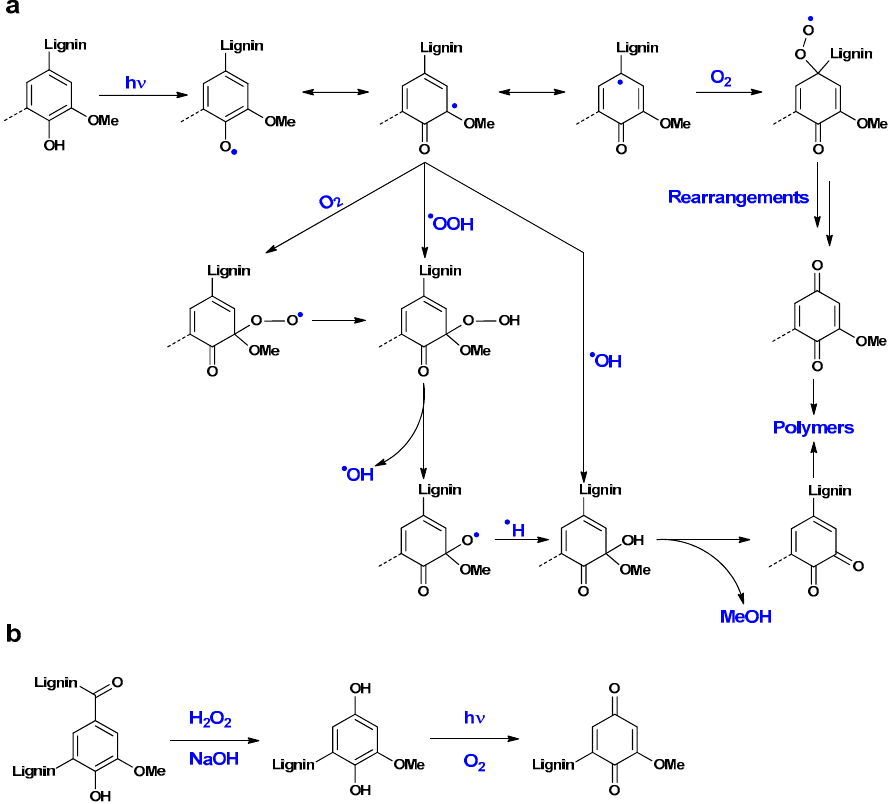
Figure 11. Quinone derivatives formation under the influence of UV irradiation ( a ) and evolution of hydroquinone formed from H 2 O 2 treatment into quinone ( b ) [40,56].